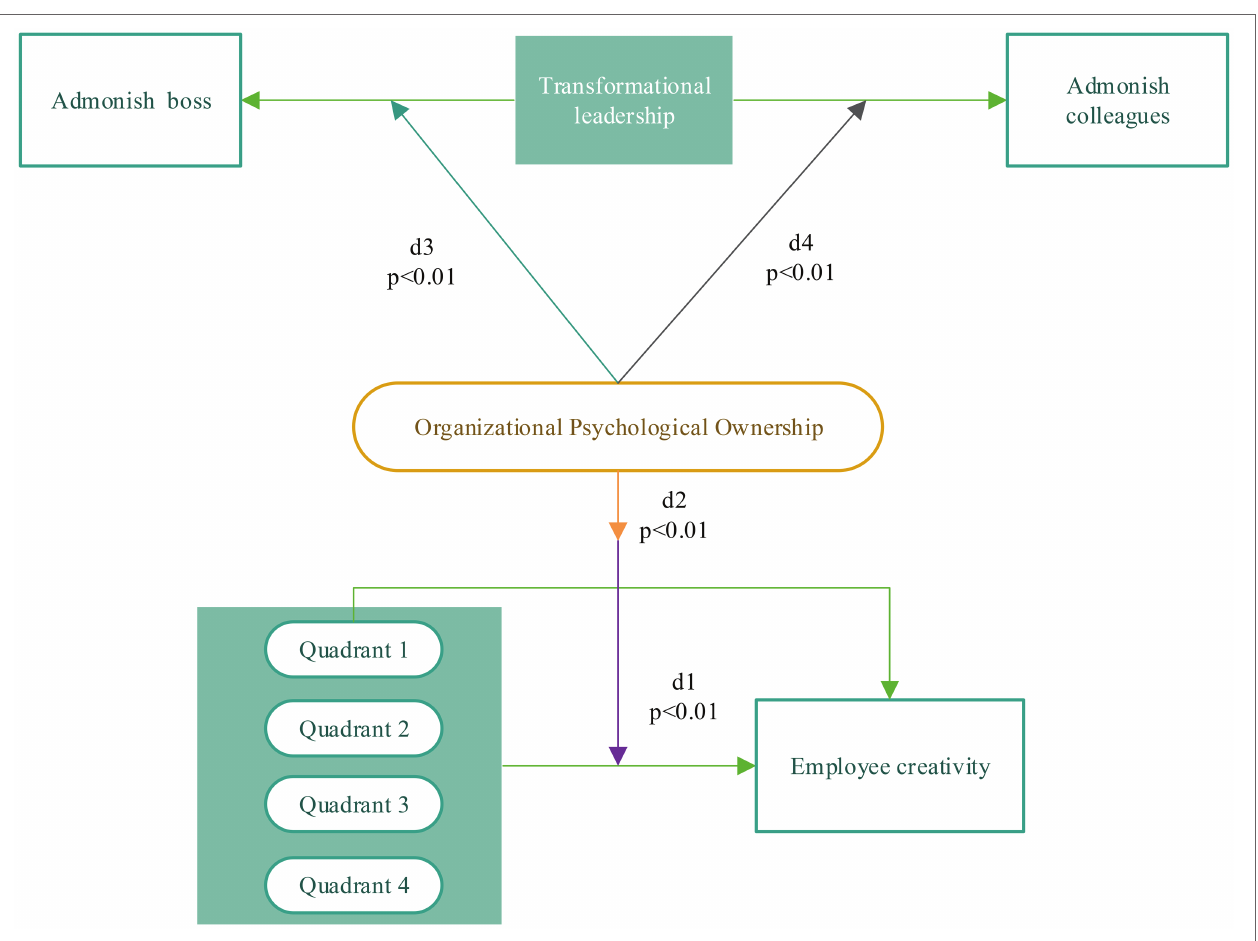
FIGURE 7 | Mediating effect modelling and p value